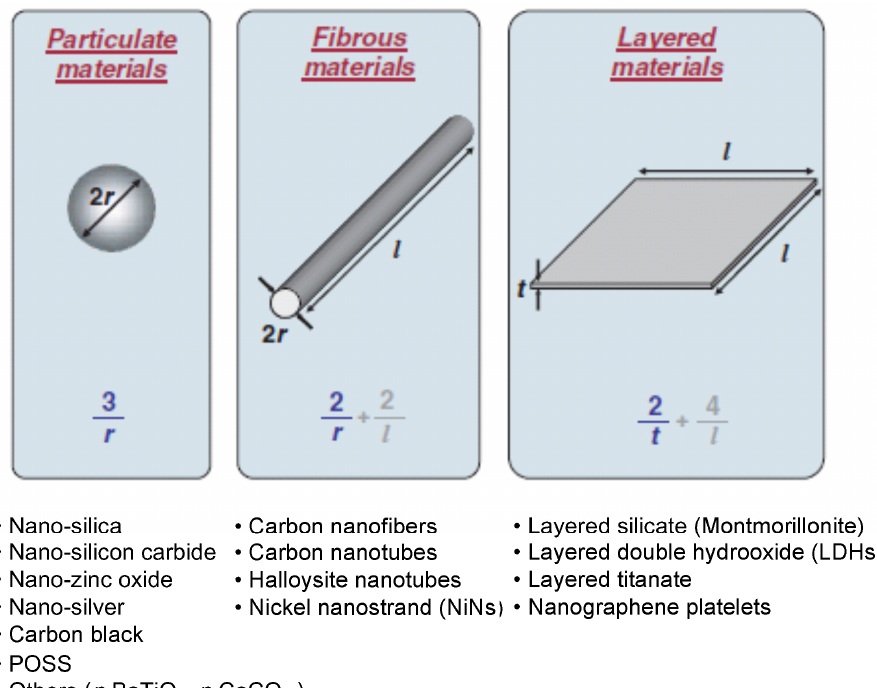
Figure 2. Common particle reinforcements/geometries and their respective surface area-to-volume ratios R . Source: Reproduced with permission from [6]. © 2005, Elsevier Ltd.